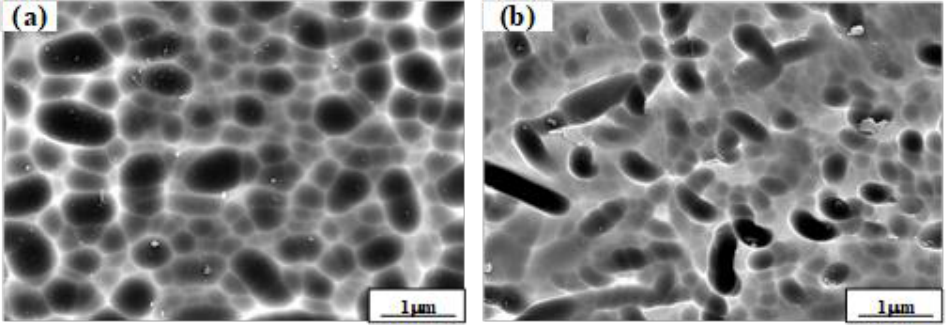
Figure 5. SEM pattern of glass-ceramics: ( a ) surface; ( b ) interior.